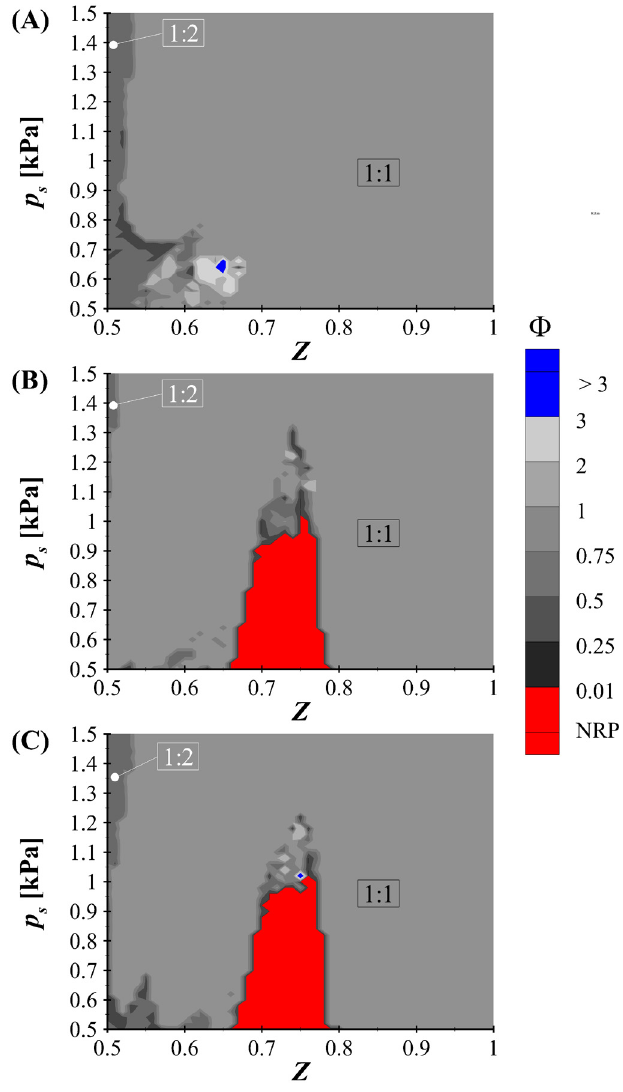
Fig 7. Regime map of the oscillation ratio. F as a function of subglottal pressure, p s , and symmetry parameter, Z , for the, A: Bernoulli-WRA (Case 1) solver, B: BLEAP-WRA (Case 2) solver, and C: BLAST (Case 3) solver. Regions denoted as no repeating pattern (NRP) denote cases for which self-sustained oscillations were not